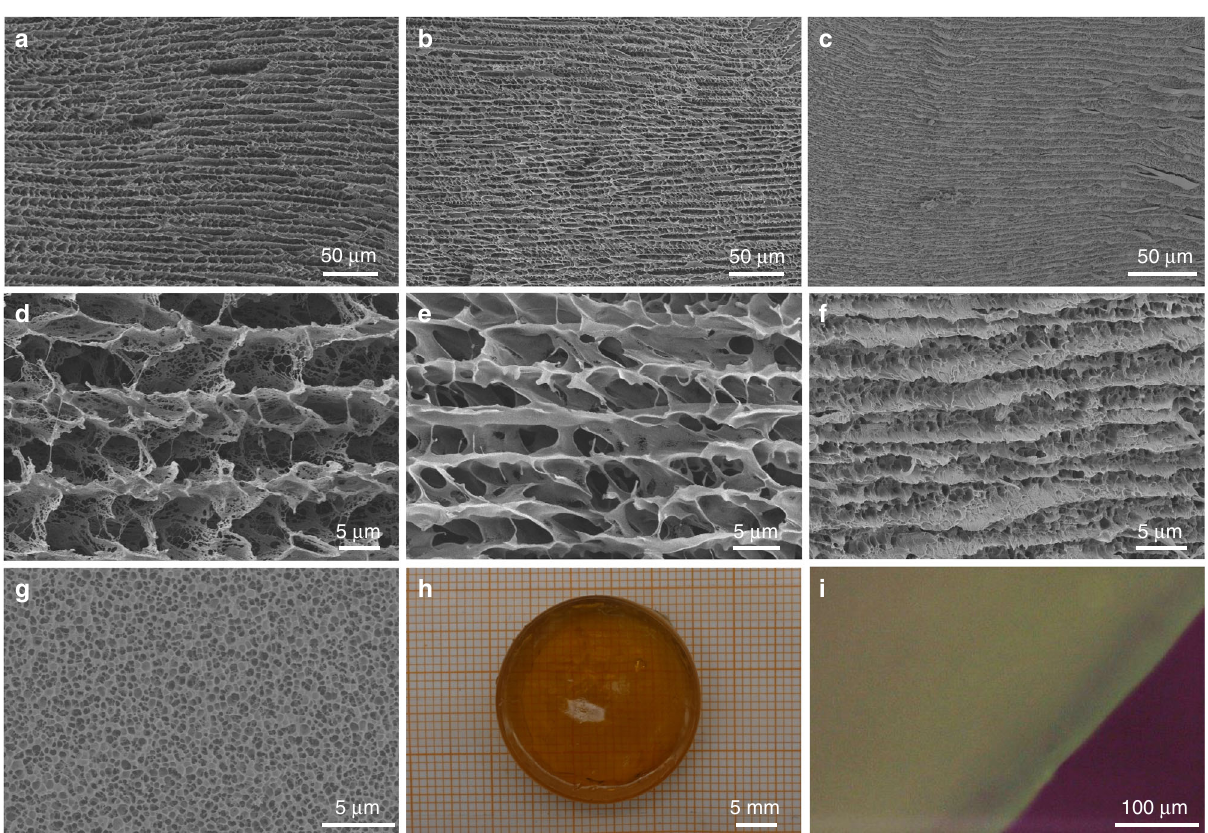
Fig. 2 Preparation of anisotropic SNPP hydrogels. Low and high magni fi cation SEM images of time-dependent network structure evolution in the polymerization process: a , d 5 min, b , e 10 min, and c , f 30 min. g SEM image of the surface of gel network. h Optical image of the hydrogel. i POM image of the gel viewed parallel to lamellar structure under cross-polarized